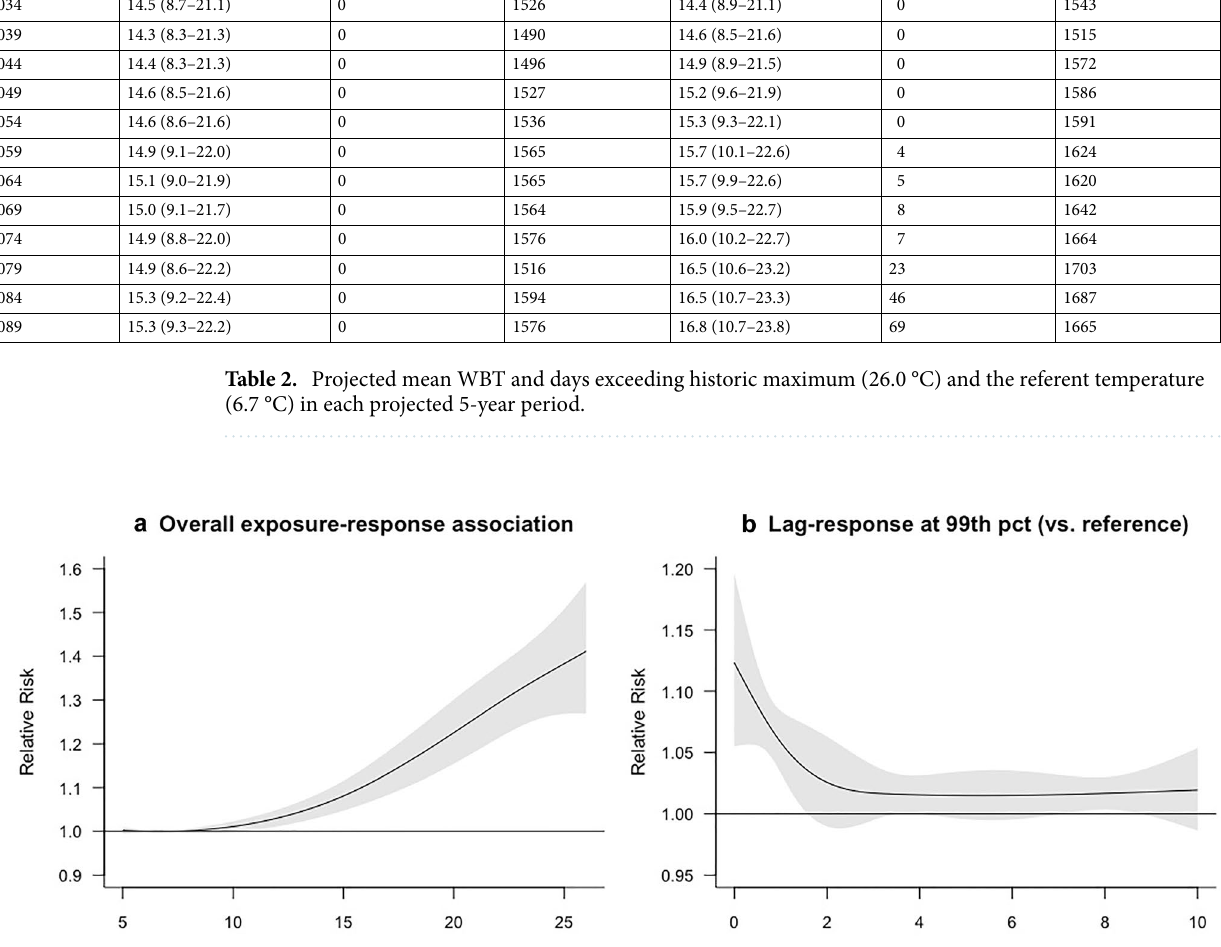
(Table 3). The increase in the proportion of heat-related kidney stone presentations per 5 year period above the 2010–2014 baseline is 0.62% and 0.77% in the 2025–2029 period and 2.2% and 3.9% in the 2085–2089 period (RCP 4.5 and 8.5, respectively).